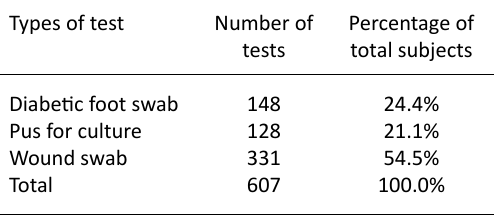
Table 2. Types of patients and cultures